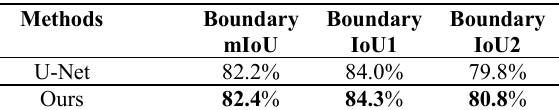
Table 5. Boundary IoU comparison on the test dataset.